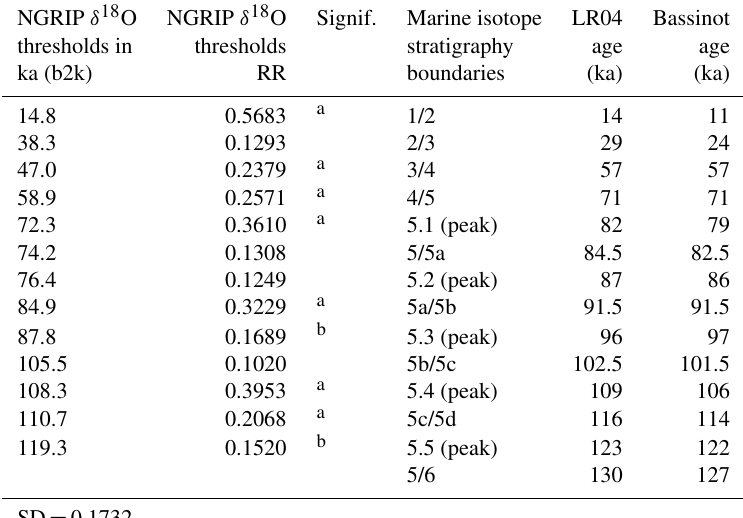
Table 3. Thresholds identified in the recurrence plot of NGRIP δ 18 O record and their correspondence in the marine isotope stratigraphy of the last climate cycle stratigraphy (Bassinot et al., 1994; Lisiecki and Raymo, 2005). RR prominence significance as in Table